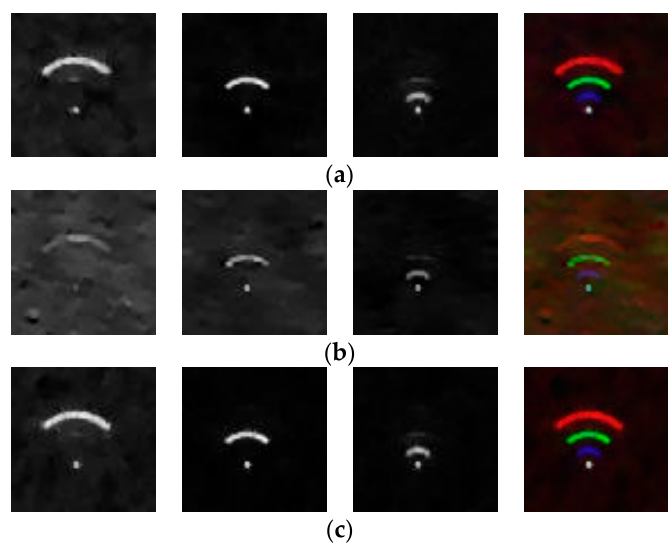
Figure 7. Results obtained by the single-pixel color camera, and the target image is color letter N: ( a ) recovered images using LCS-MM, PSNR = 19.80 dB, SSIM = 0.19; ( b ) recovered images using LCS- CMM, PSNR = 18.18 dB, SSIM = 0.08; ( c ) recovered images using LCS-PRC-MM, PSNR = 20.17 dB, SSIM = 0.20.